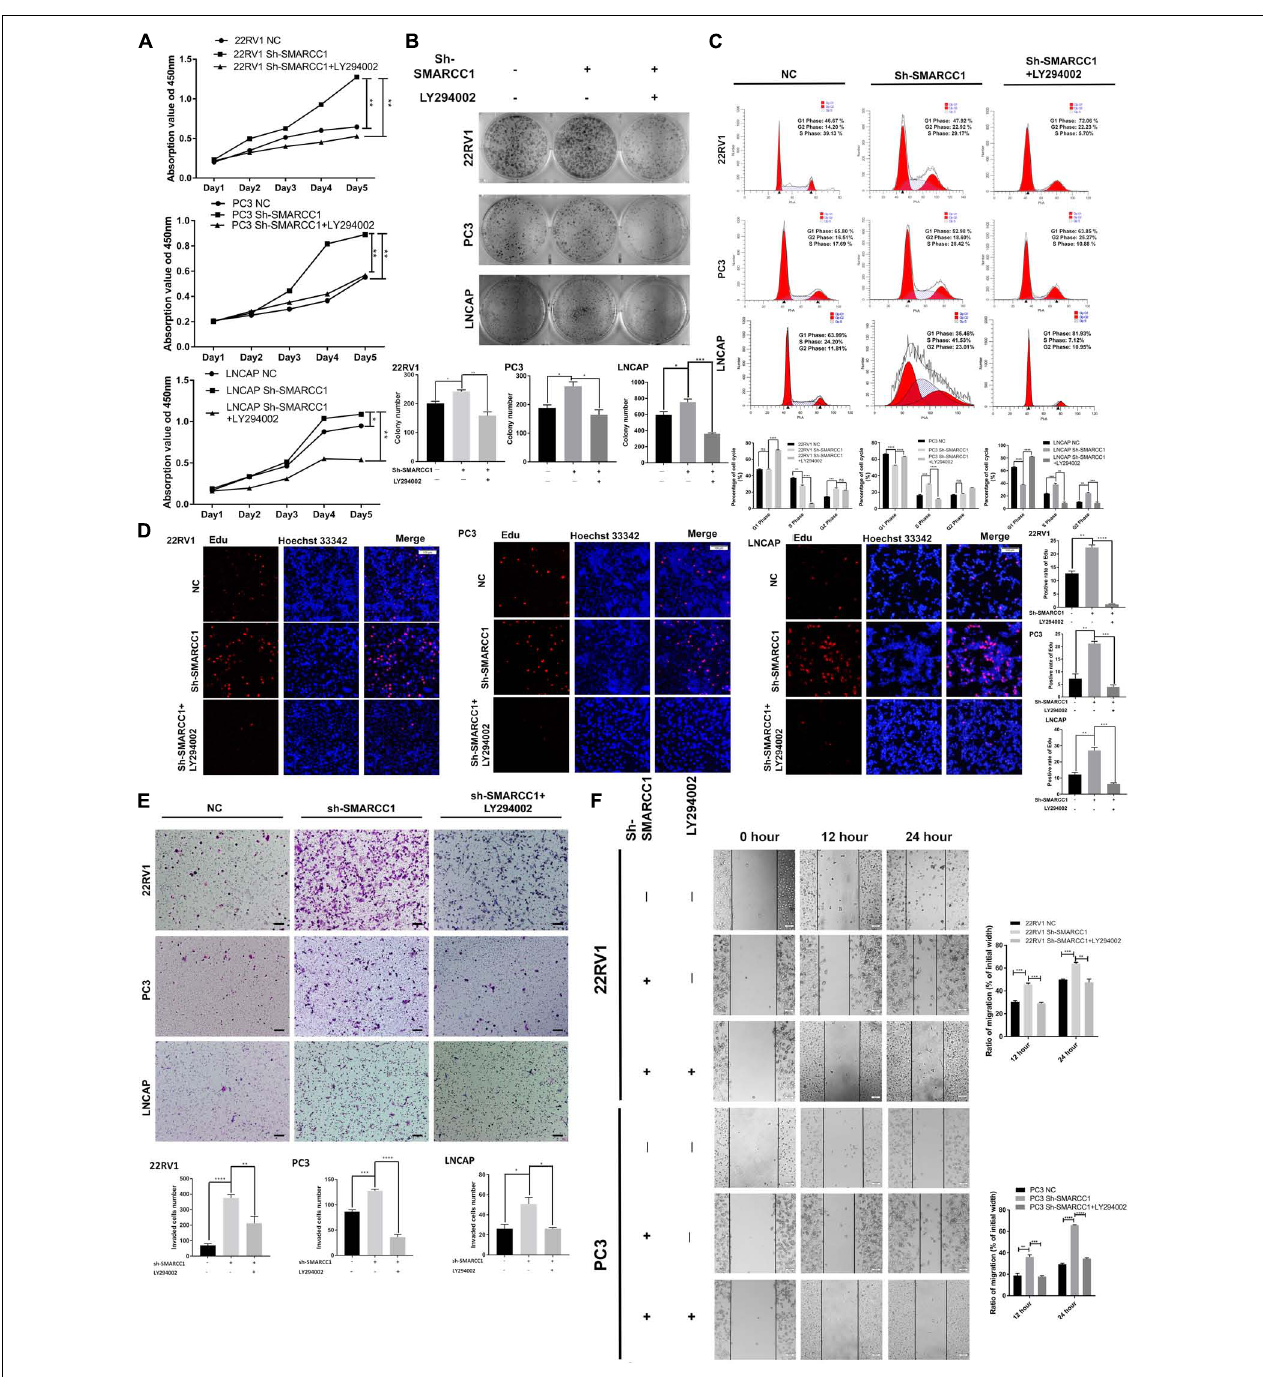
FIGURE 6 | PI3K/AKT pathway blockade reversed the phenotypic effect of SMARCC1 knockdown. (A) Viability rate, (B) number of colonies, (C) cell cycle distribution, and (D) Representative image of EdU for LNCAP with Sh- SMARCC1 was selected from area presented in Figure 2E for LNCAP cell line with Sh- SMARCC1 . (E) Transwell assay on SMARCC1 knocked-down PCa cell lines treated with ly294002 (scale bar – 100 µ m). (F) Wound healing assay on migration ability of SMARCC1 knocked-down PCa cell lines treated with ly294002. All data are presented as mean ± SEM of at least three independent experiments. * p < 0.05; ** p < 0.01; *** p < 0.001; **** p < 0.0001.